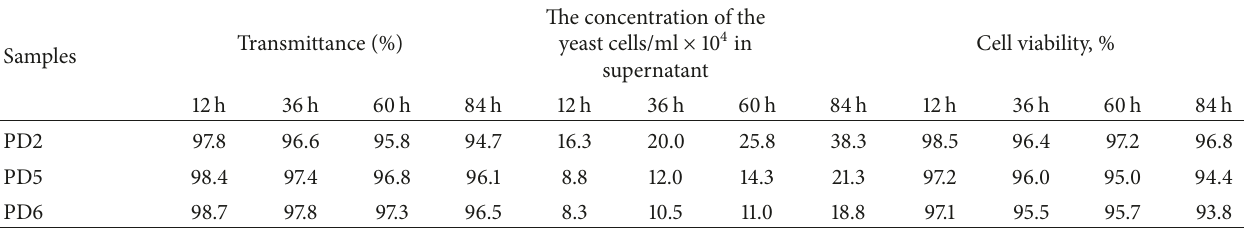
Table 5: Influence of the alcoholic medium on the stability and viability of the yeast cells immobilized in gellan particles.